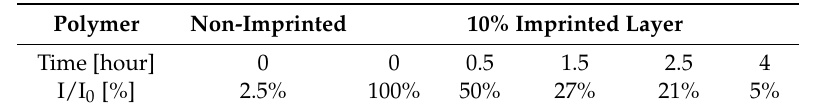
Comparison of fluorescence intensity (Perkin-Elmer LS-50B—spectrometer) of 10% naphthalene imprinted polymer layer at different evaporation